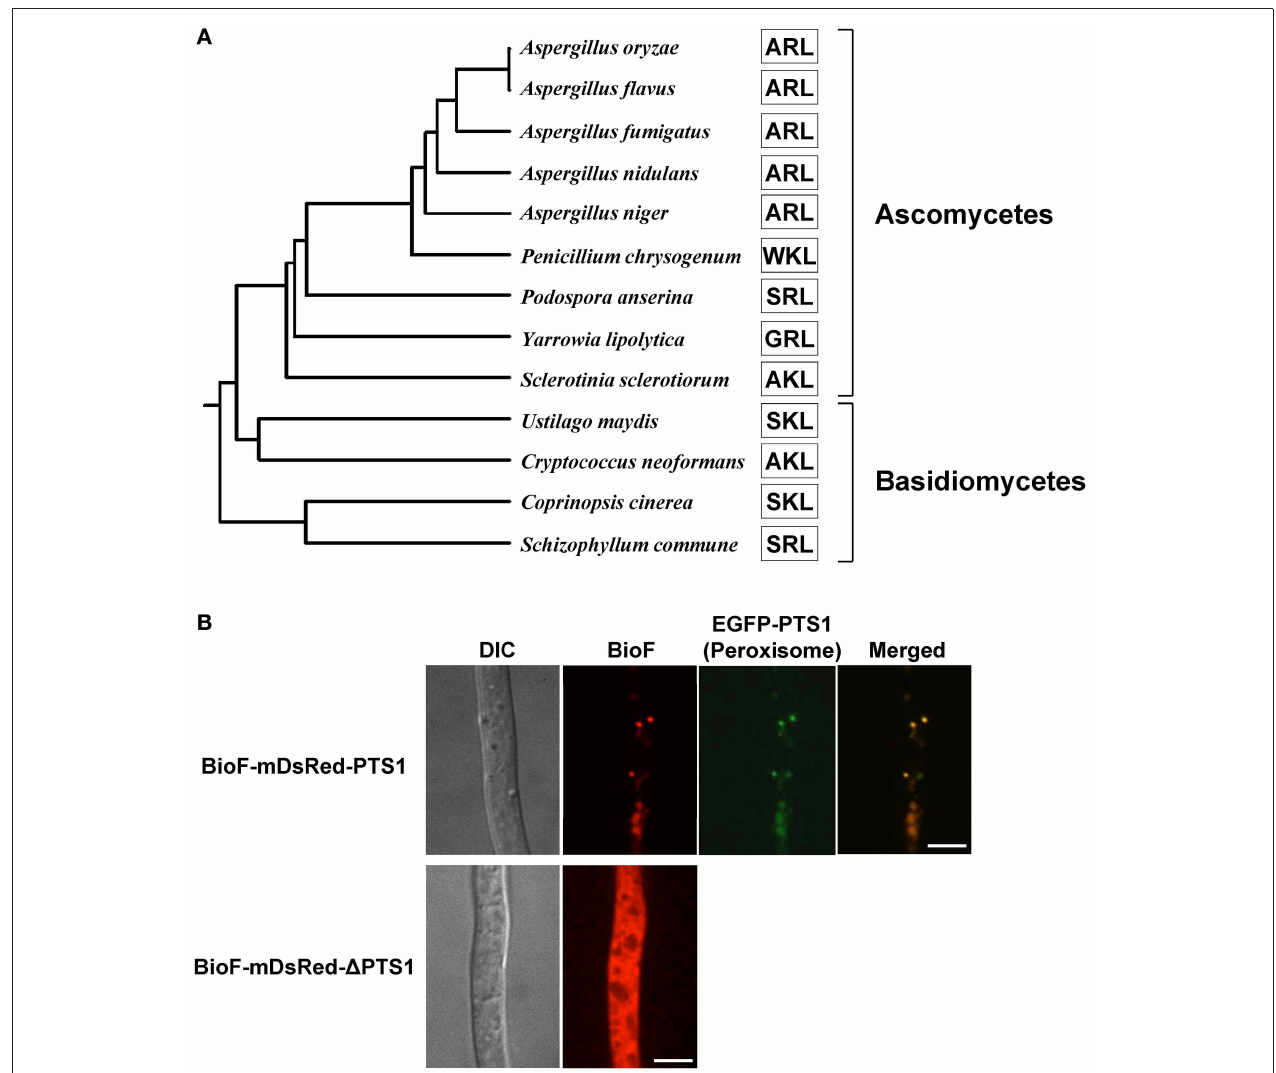
FIGURE 5 | Phylogenetic relationship and peroxisomal localization of fungal BioF proteins. (A) Phylogenetic analysis of fungal BioF proteins. The amino acid residues of the C-terminal peroxisomal targeting signals (PTS1) are indicated by open boxes. The full-length amino acid sequences of the fungal BioF proteins were aligned using the Clustal W program (version 2.1), and then the phylogenetic tree was constructed. The Genbank accession numbers for the sequences used in the analysis are as follows: Aspergillus oryzae , XP_001817022.1; Aspergillus flavus , XP_002383037.1; Aspergillus fumigatus , XP_747713.1; Aspergillus nidulans ,